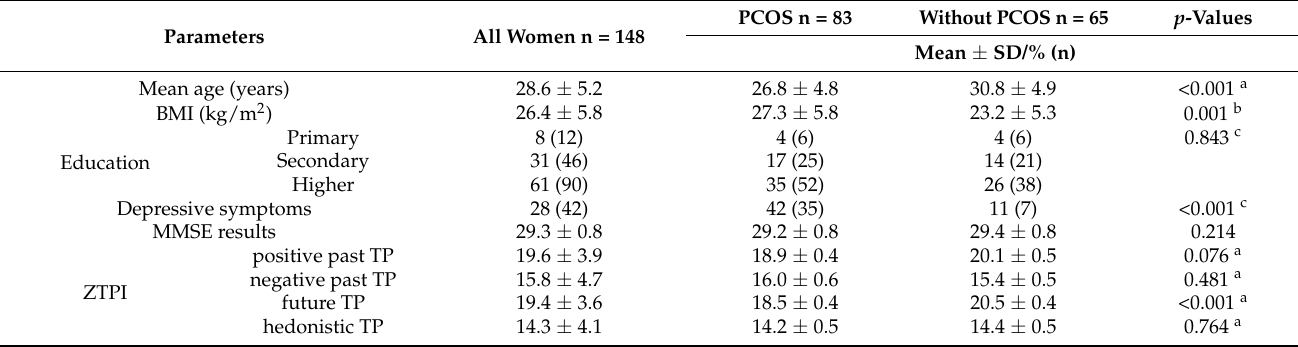
Table 1. Group characteristics.